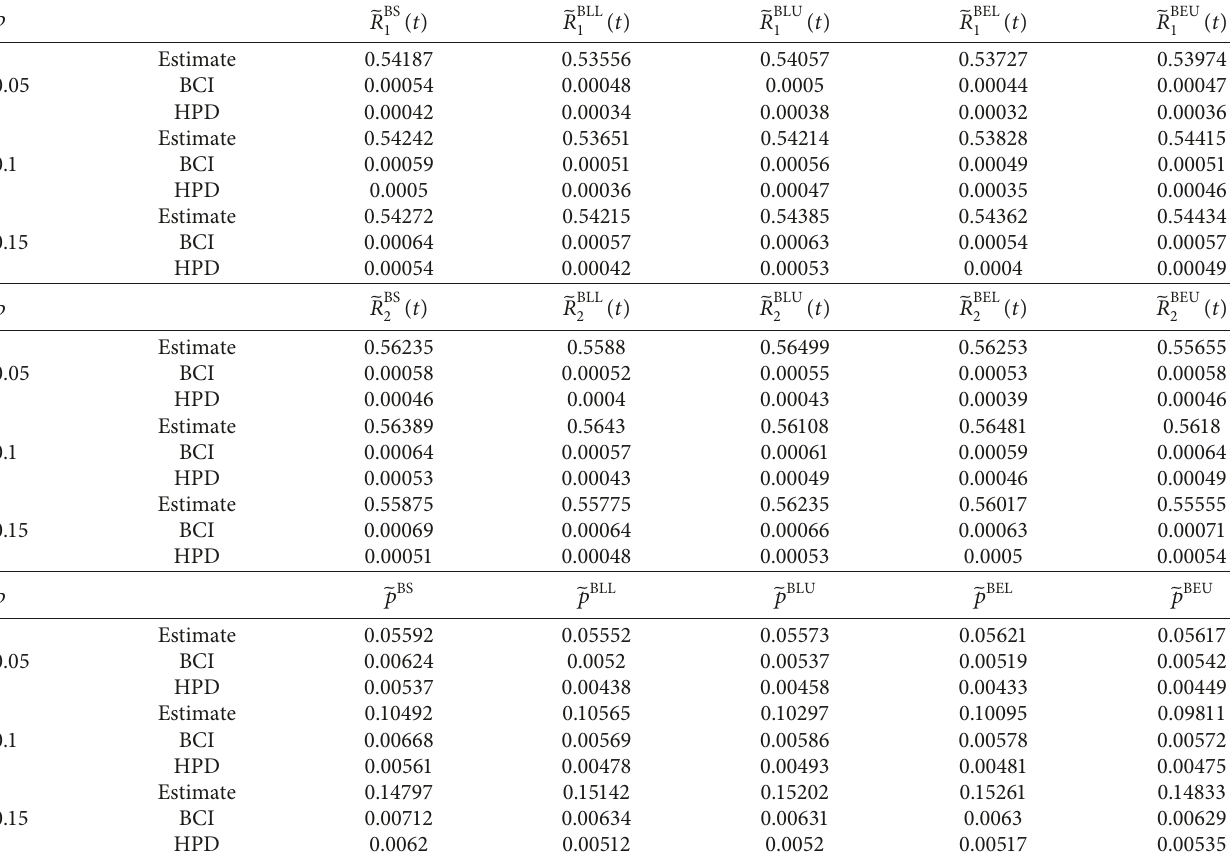
( t ) , R ( t ) and p with their length of CI for different m for n and p . 1 2